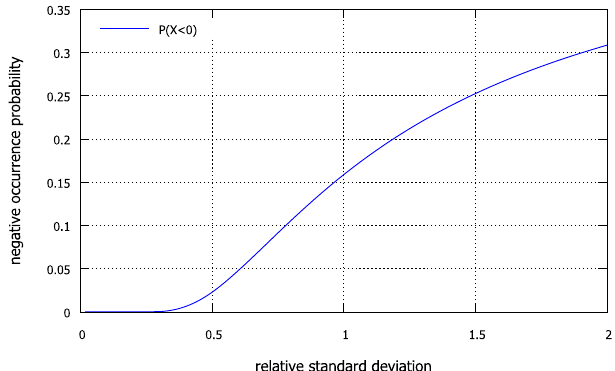
Fig. 1. Probability of negative occurrences for non truncated